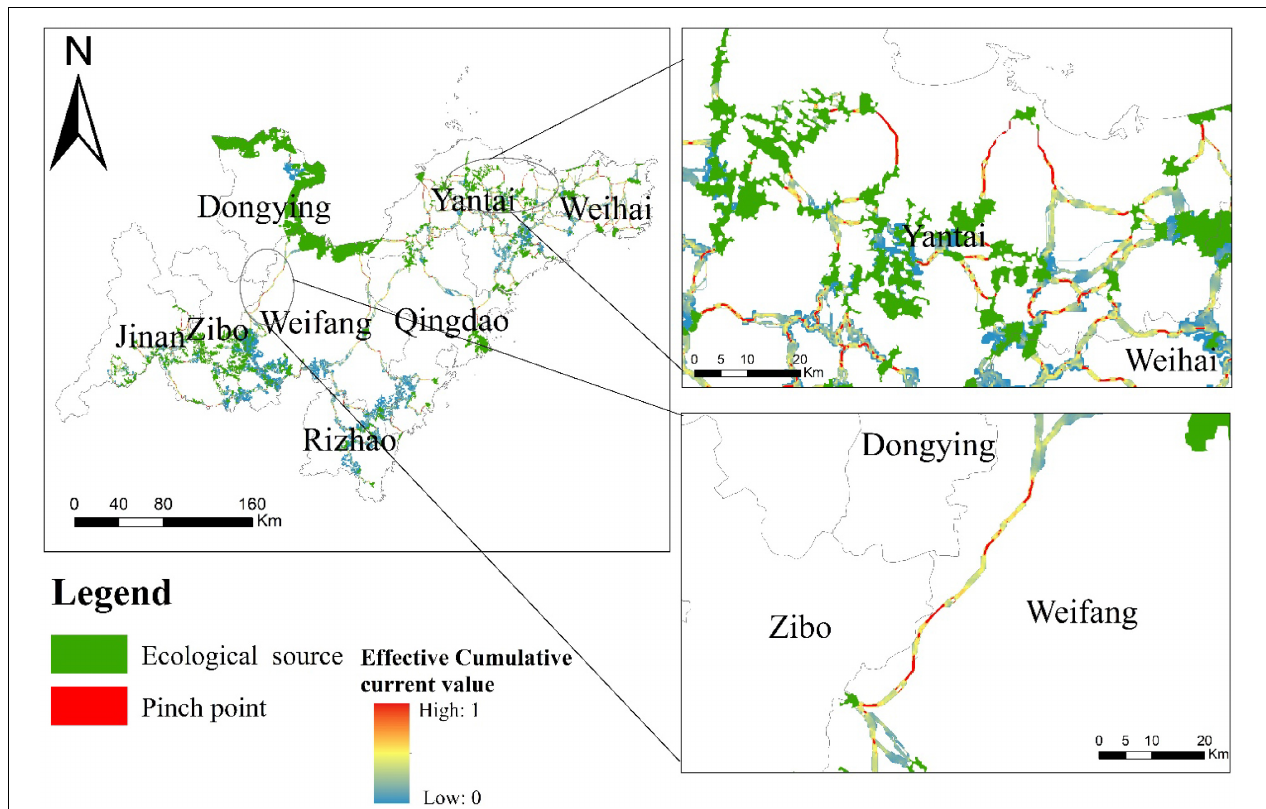
FIGURE 10 | Spatial distribution of conservation priority areas in the ENs of Shandong Peninsula urban